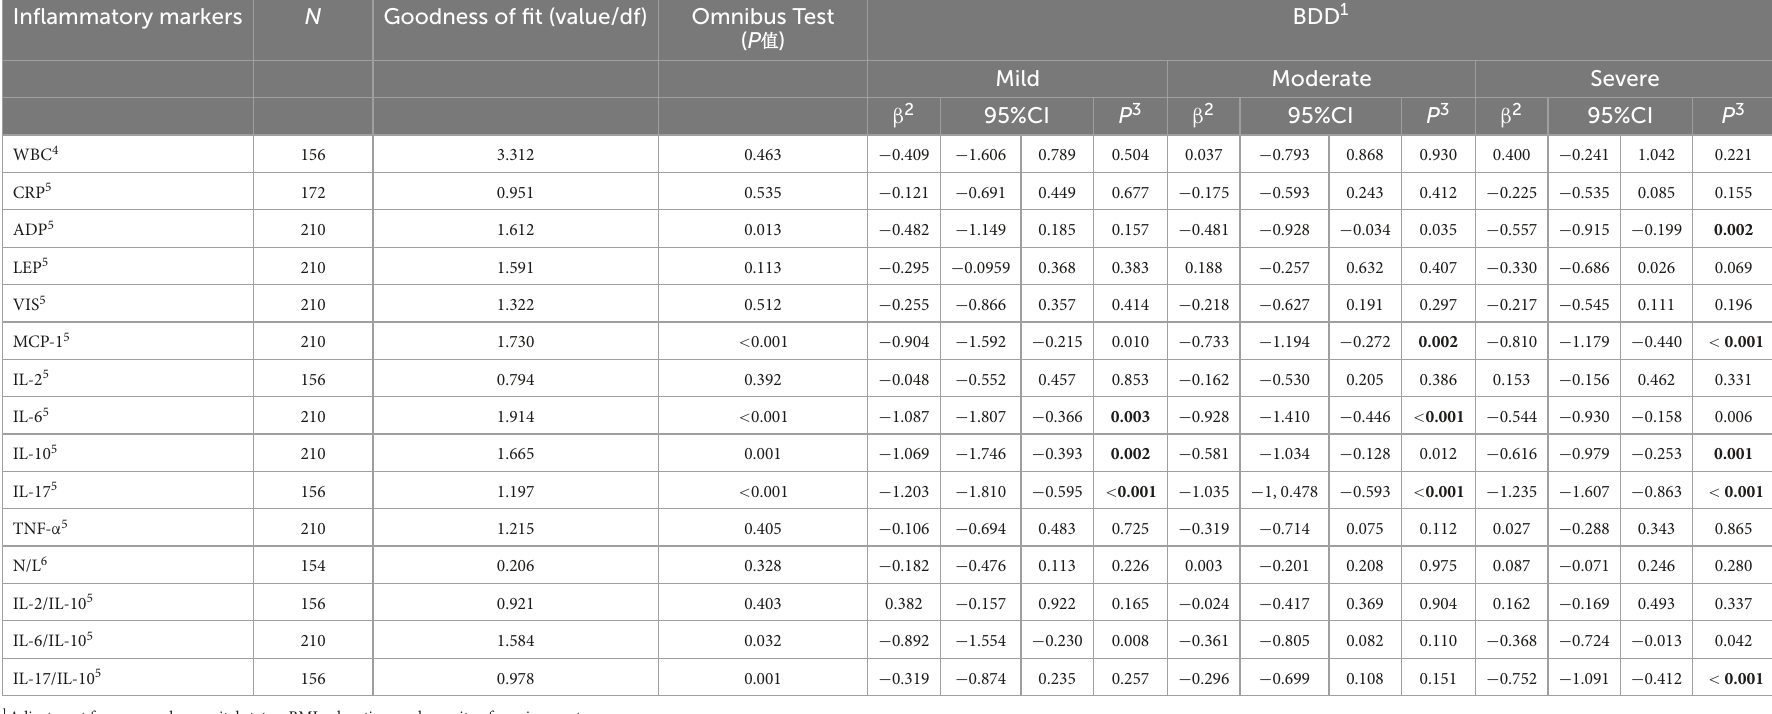
TABLE 5 The association between severity of depressive symptoms and serum level of inflammatory markers. Inflammatory